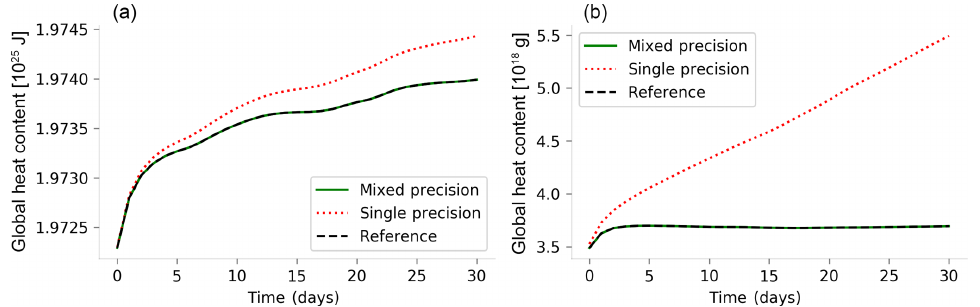
Figure 1. Daily averages of the global heat content (a) and global salt content (b) for 1-month simulations using NEMO 4. The plot of the global salt content (b) has an offset of 4 . 731 × 10 22 g. The reference simulation was performed using double precision, the single-precision simulation was performed using single-precision arithmetic for all the variables and the mixed-precision simulation was performed keeping 40 of the 942 model real variables in double precision and using single precision for the remaining 902 variables.